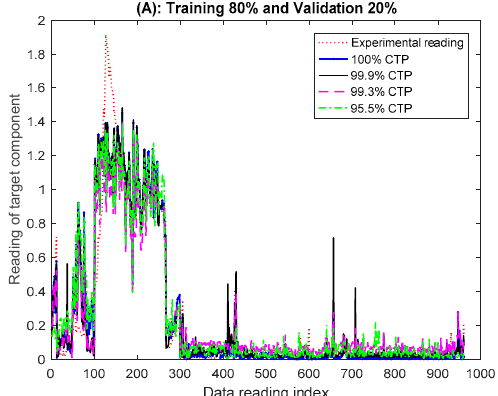
Figure 5. Comparison of the experimental and the cross-validation ensemble ANN predicted target sensor readings for the 95%, 99.3%, 99.9% and 100% levels of the Cumulative Target-component Percentage-influence (CTP) of the validation dataset.